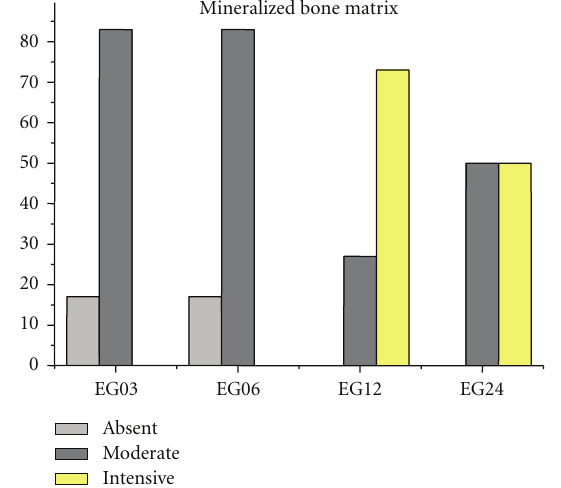
Figure 13: EGs collapse of neoformed tissue was 100% absent in